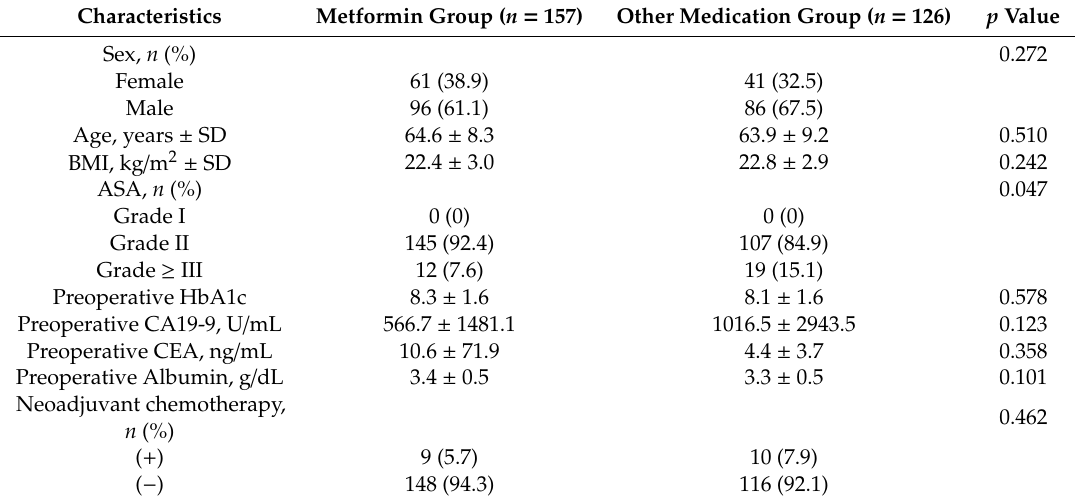
Figure 2. Flow chart summarizing the study identification and selection. Table 1. Demographic and preoperative data of the metformin group and the other medication group.